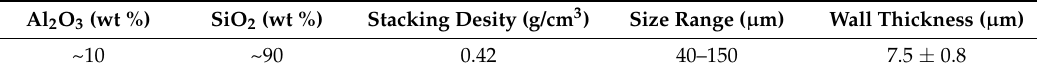
Table 2. Composition and parameter of ceramic microspheres